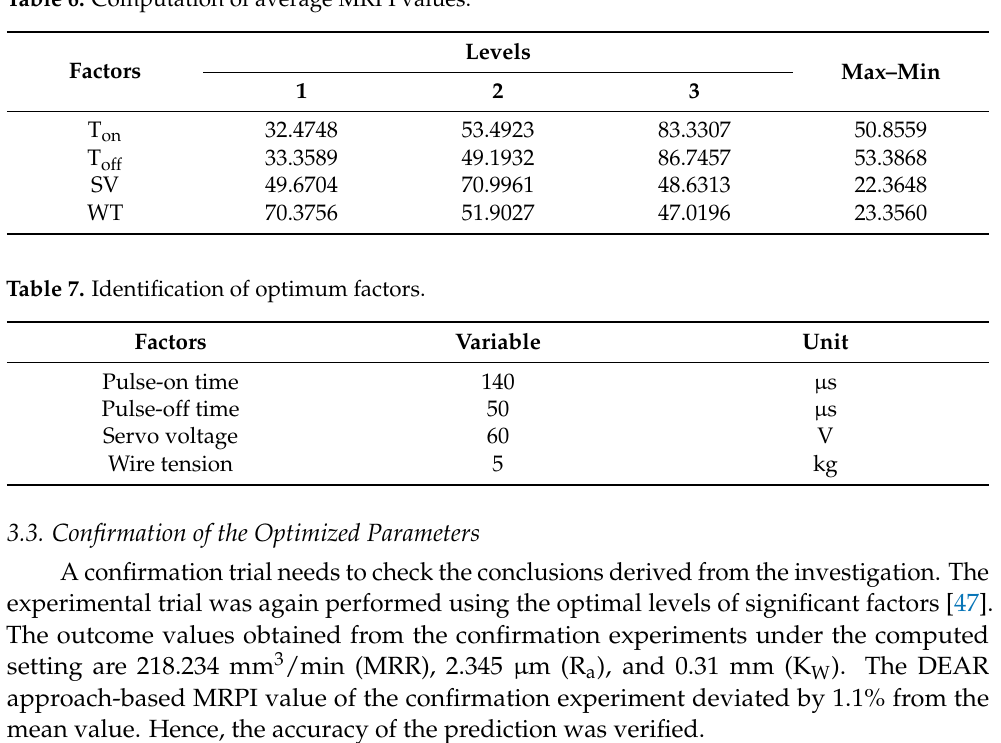
Table 6. Computation of average MRPI values.